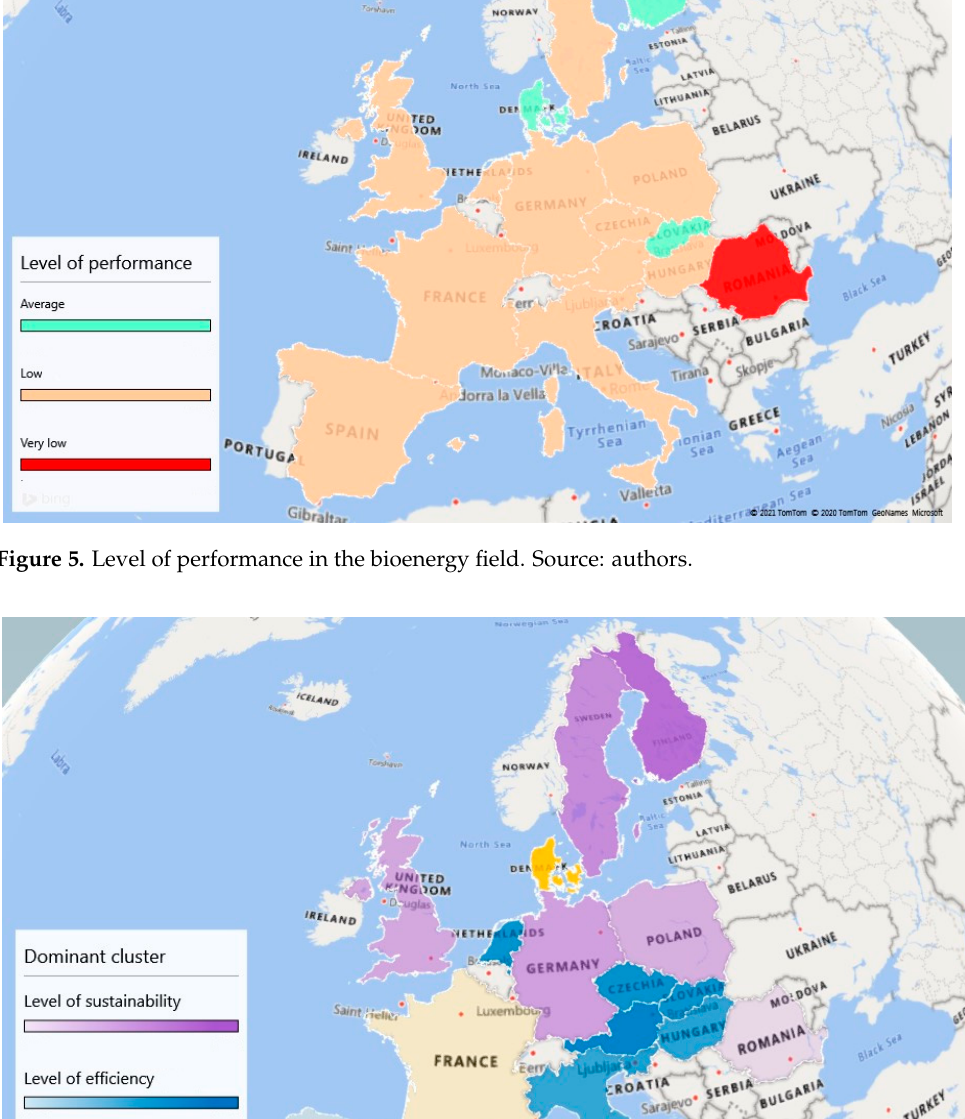
Table 8. Robustness assessment. No.